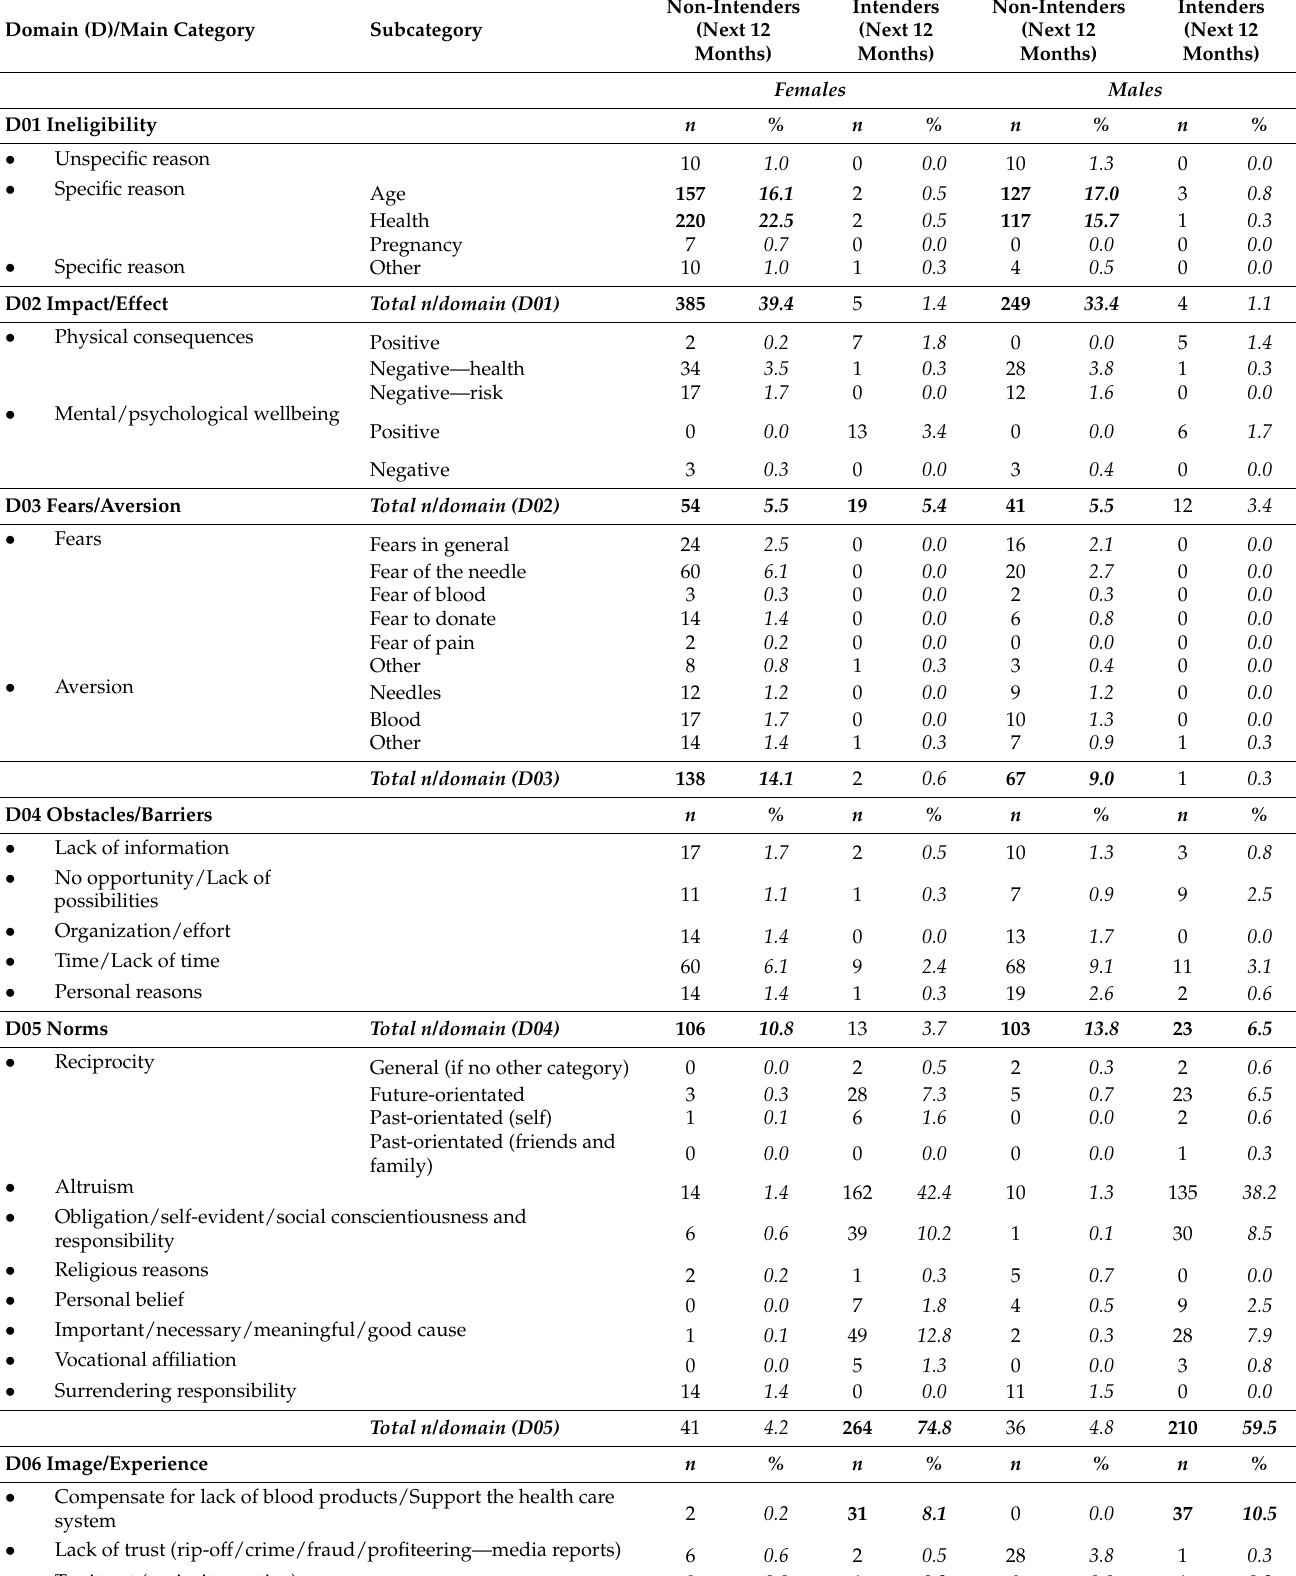
Table A5. Self-reported motivators and deterrents for prospective (12 months) blood donation behaviour—results for different donor types and separated for sex ( n = 2531, unweighted)